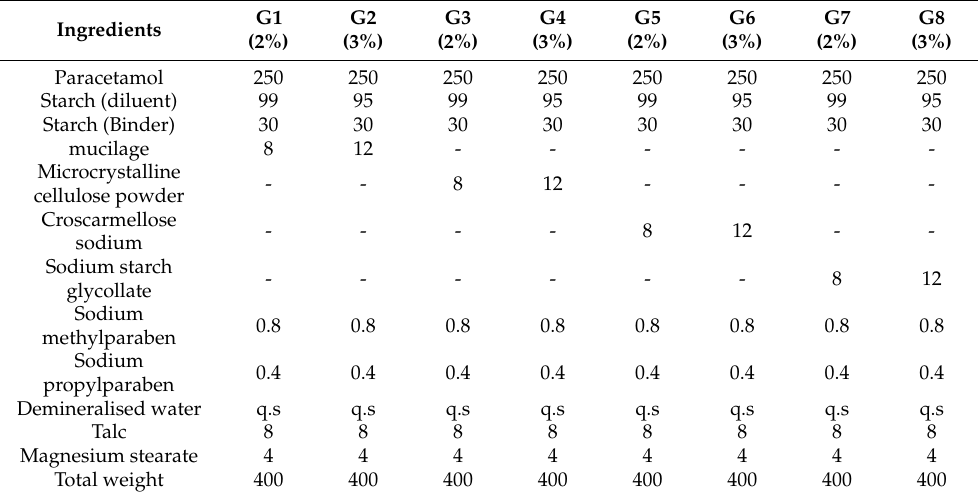
Table 2. Composition of paracetamol tablet formulation using the different disintegrating agents of Coccinia grandis mucilage, MCCP, CCS, and